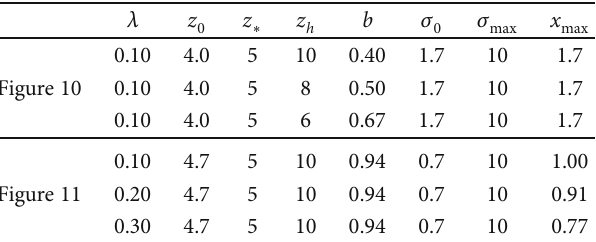
Table 6: Parameter values used for plots in Section